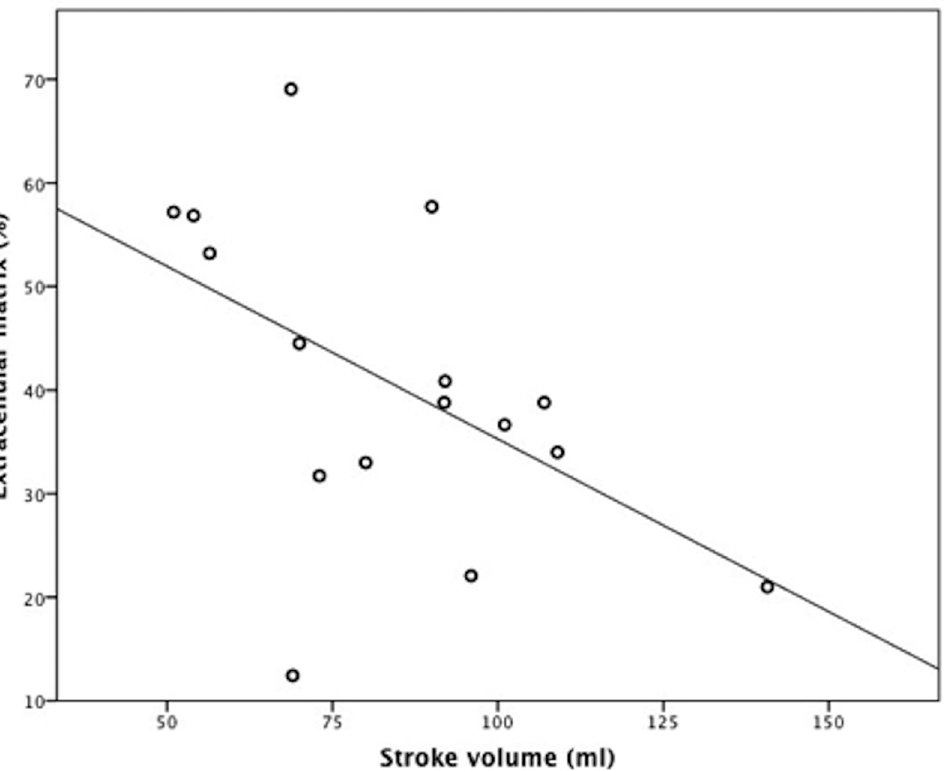
Fig 3. Correlation between the extent of left ventricular extracellular matrix and invasively measured stroke volume (r = -0.53; p = 0.04). Four patients with myocardial biopsy were not eligible for CMR study due to